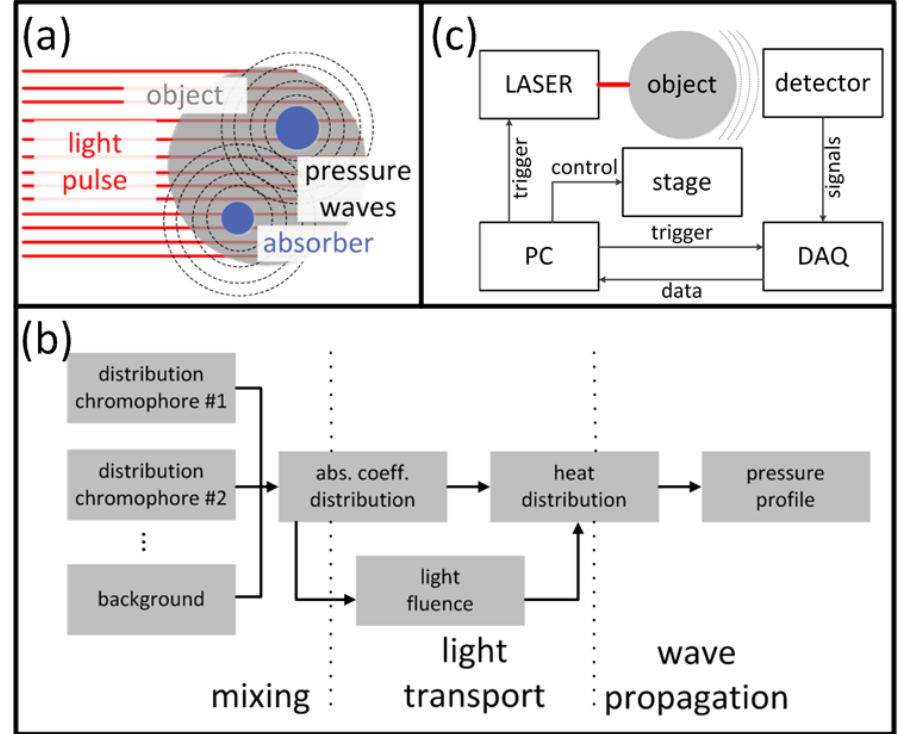
Figure 1. ( a ) Illustration of the optoacoustic effect. The object is illuminated with a light pulse and photons are absorbed within the object. The optical energy is converted to mechanical energy and gives rise to propagating pressure waves; ( b ) Schematic of the main physical processes involved in optoacoustic imaging: The distributions of different chromophores contribute to optical absorption and they mix to the spatially varying absorption distribution. The transport of light determines the local heat distribution by both absorption distribution and light fluence. The deposited heat excites pressure waves which propagate to the detectors’ locations according to acoustic wave equation; ( c ) Schematic of a typical setup for optoacoustic imaging: A laser illuminates the object. The pressure waves are captured by one or many detector/s and their signals are digitized by a data acquisition system (DAQ). A stage moves the object relative to the detector for capturing multiple projections. A PC controls the imaging process and stores the